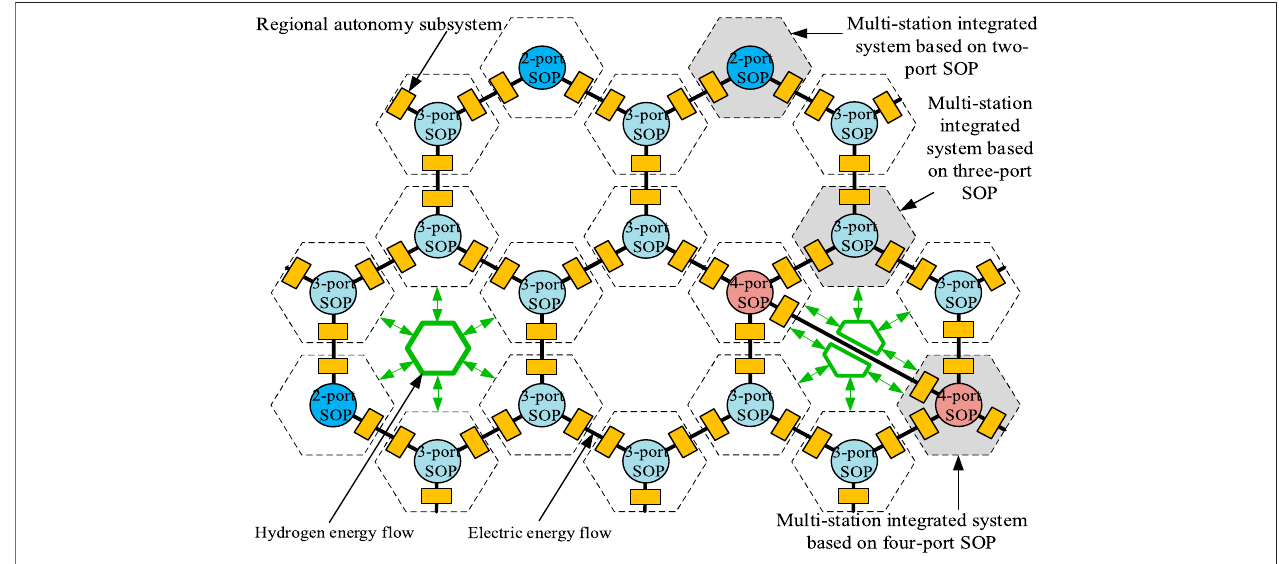
FIGURE 1 | Schematic diagram of honeycomb grid